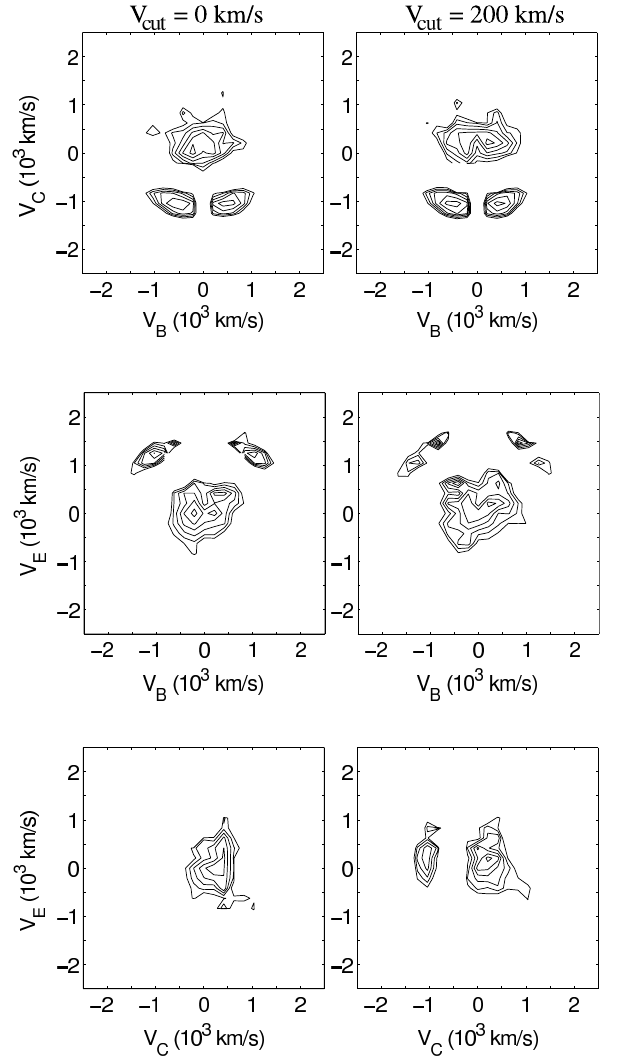
Fig. 17. Two-dimensional cuts of the model velocity distribution calculated at (X,Z) = ( − 22 , 0 . 0001 ) R E . The velocities are ex- pressed in terms of the directions of the magnetic field ( V B ), electric field ( V E ) and convection velocity( V C ). The top row shows cuts in the V B − V C plane at V E = 0km/s (left) and 200km/s (right). The middle row shows cuts in the V B − V E plane at V C = 0km/s (left) and 200km/s (right). The bottom row shows cuts in the V C − V E plane at V B = 0km/s (left) and 200km/s (right). At this location V C ≈ V x ,V B ≈ V z ,V E ≈ V y .